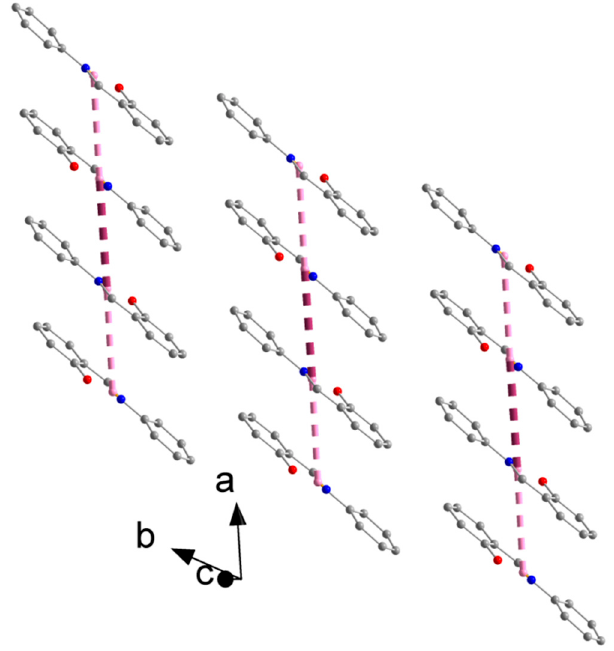
Figure 10. A layer of lattice salanH molecules parallel to the (001) plane in the crystal structure of 18 _Dy. The dashed light violet-orange and mauve lines indicate the two types of overlap.